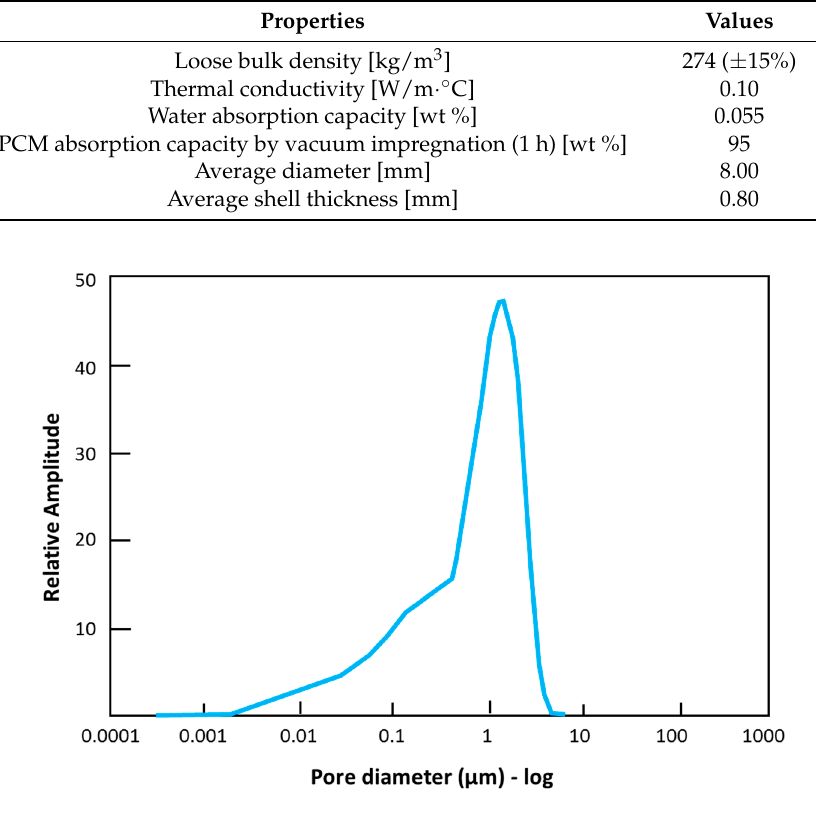
Figure 3. Pore size distribution of the LWA.